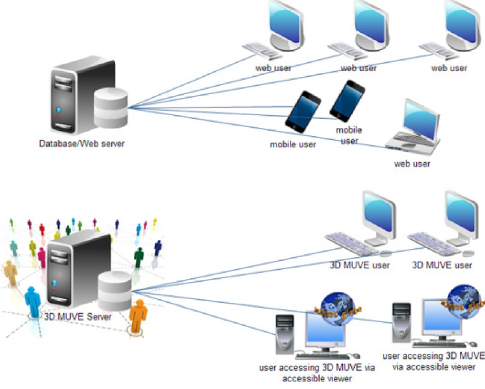
Figure 5. Functionality of the accessible MUVE viewer and web